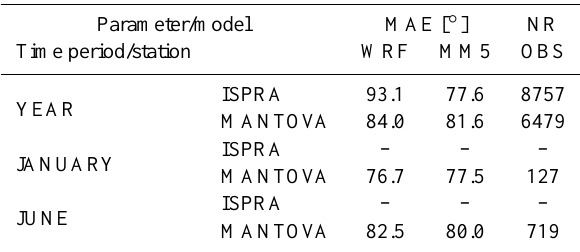
Table 3d. Statistics for the wind